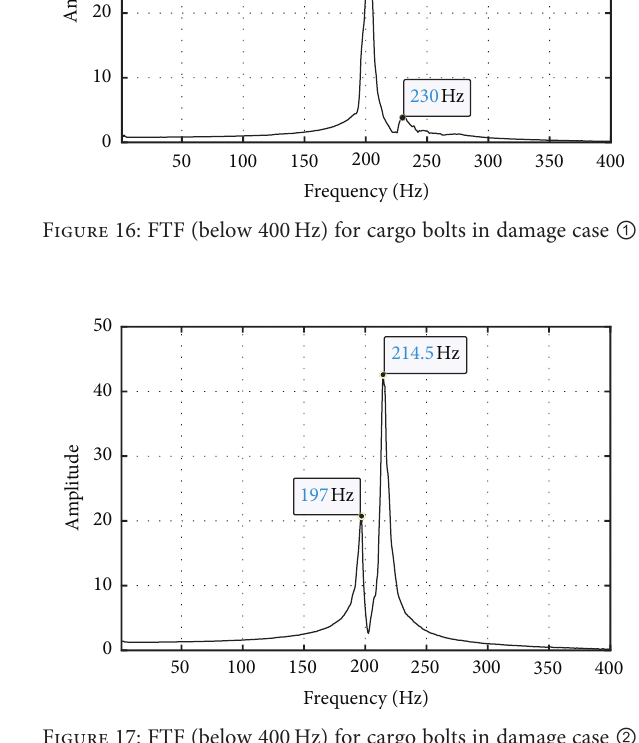
Figure 17: FTF (below 400Hz) for cargo bolts in damage case ②